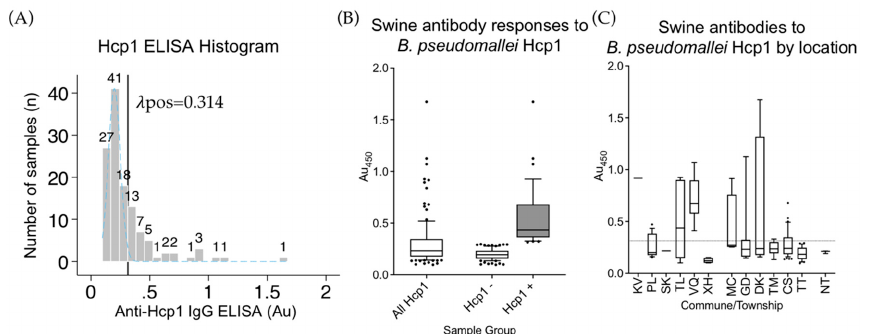
Figure 2. Anti-Hcp1 IgG ELISA. ( A ) A histogram of 133 swine serum samples from Vietnam tested for anti-Hcp1 IgG antibodies. The cuto ff threshold for the Hcp1 ELISA assay is indicated by the vertical black line at 0.314 Au. The light blue dashed line indicates the normal distribution of the CPS seronegative population. The numbers above each bar indicate the total number of samples in each of 22 bins. ( B ) The absorbance values obtained from the Hcp1 ELISA of 133 swine serum samples (all Hcp1), those not passing cutoff (Hcp1-), and those passing cutoff (Hcp+). ( C ) Swine antibody responses by commune/township as detected in the Hcp1 ELISA. The dotted line indicates calculated cutoff value of 0.314 Au. Boxes are the interquartile range. Whiskers indicate the 10th and 90th percentiles. Black dots indicate individual samples outside of these ranges. Location codes can be found in Table 1.